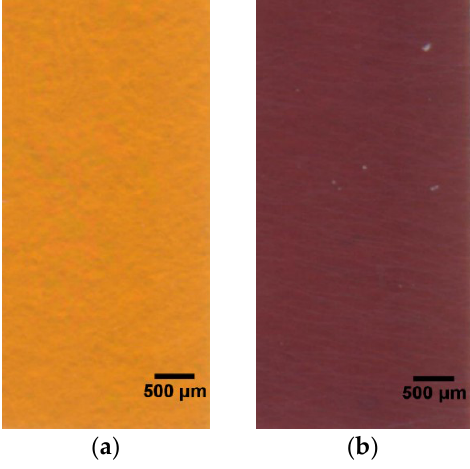
Figure 4. Macroscopic picture of Kapton film ( a ) and Kapton / Al 2 O 3 nanocomposite film ( b ).